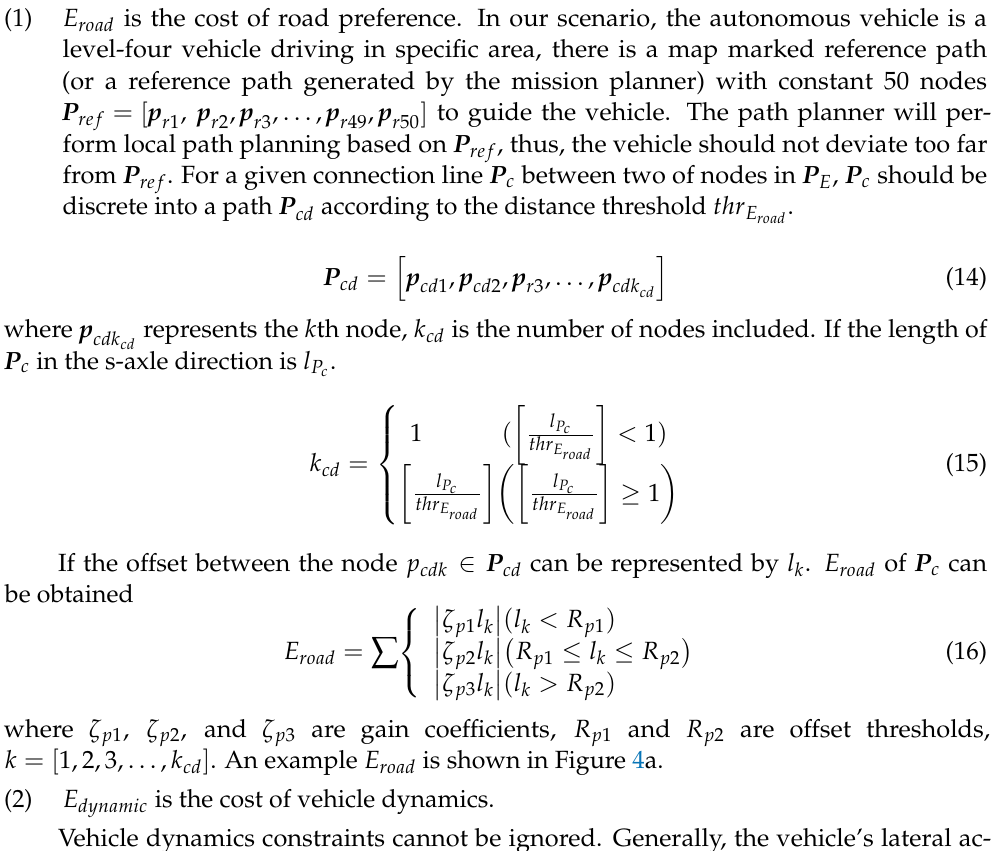
. Figure 11. An example of smoothed P b 𝑷𝑷 𝑏𝑏